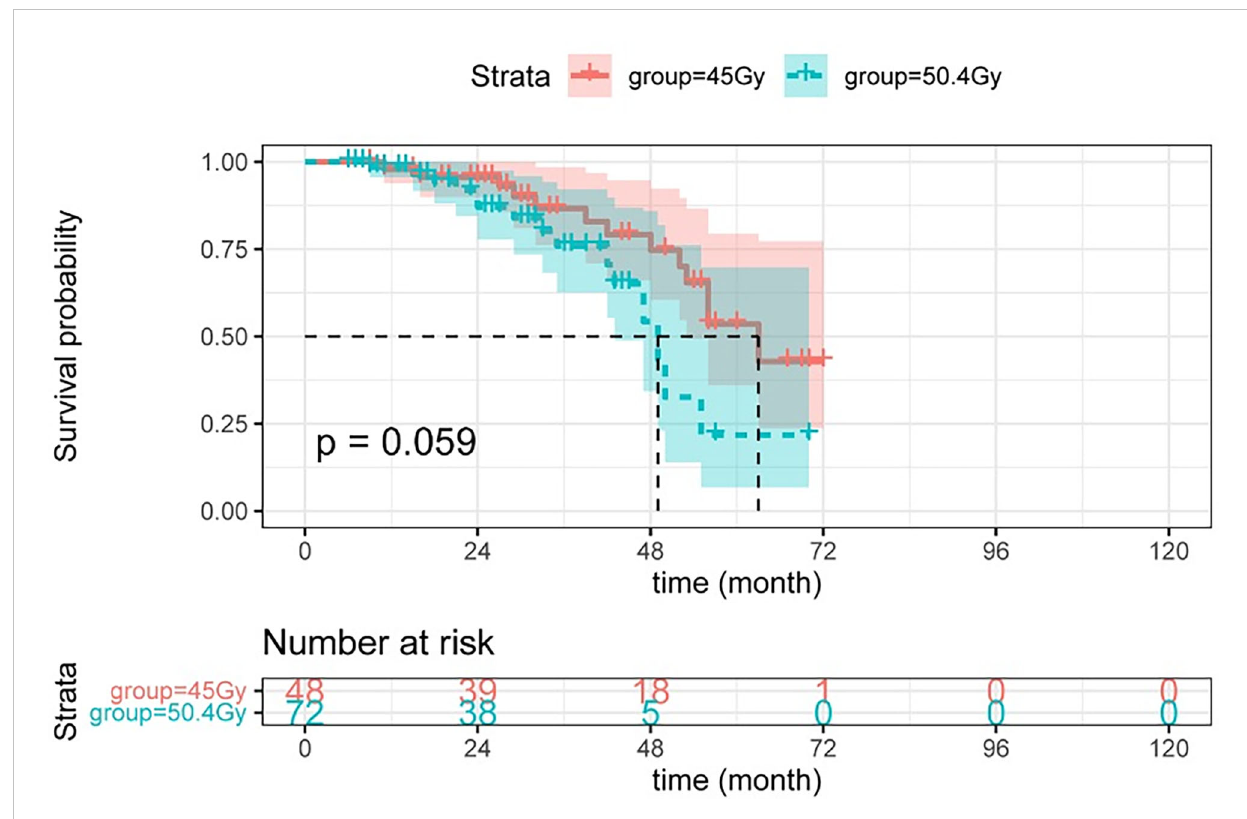
FIGURE 4 The OS between LARC patients with different radiation doses. OS, overall survival; LARC, locally advanced rectal